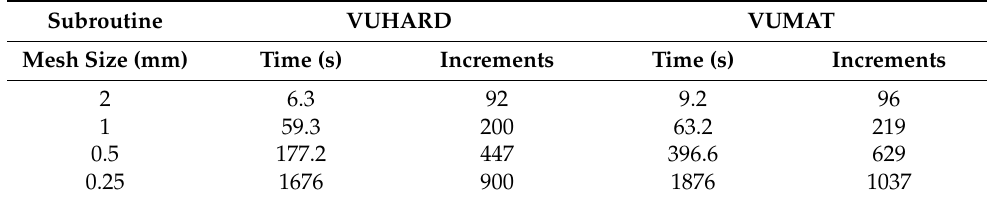
Table 4. Computation time and number of increments for different mesh densities.